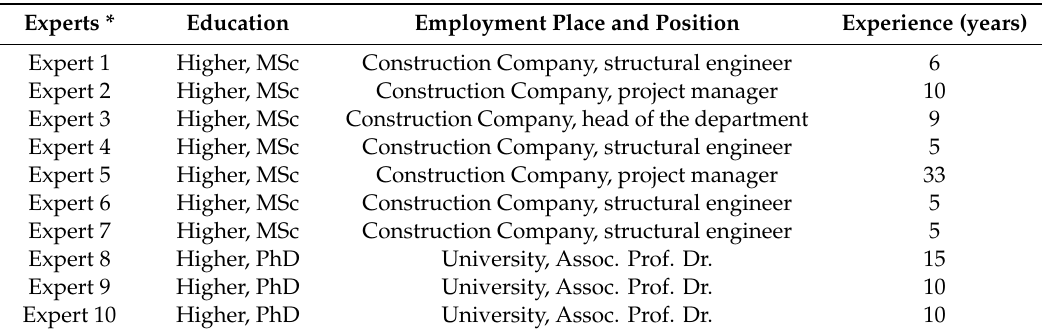
Figure 3. The iterations of Delphi technique adapted for the study. Table 2. Characteristics of